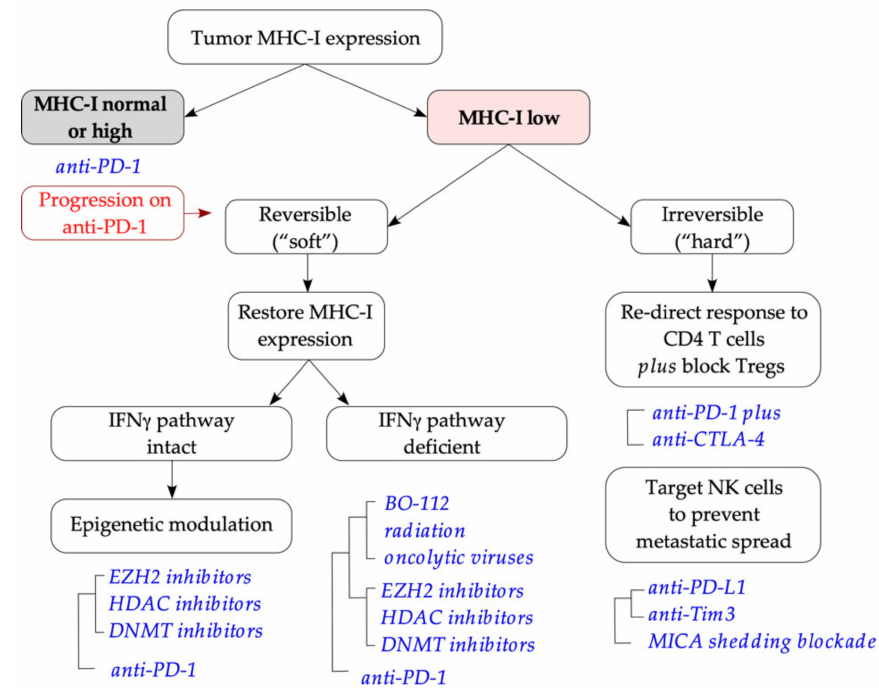
Figure 4. Proposed strategies of immunotherapy selection based on tumor MHC-I cell surface expression. Patients with adequate tumor cell surface MHC-I expression are selected for the first line anti-PD-1 monotherapy (progression while on therapy warrants consideration of other